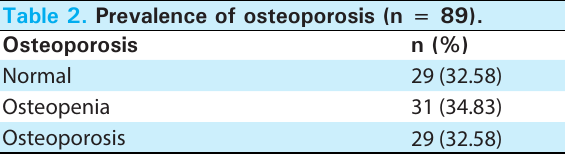
Table 2. Prevalence of osteoporosis (n = 89).